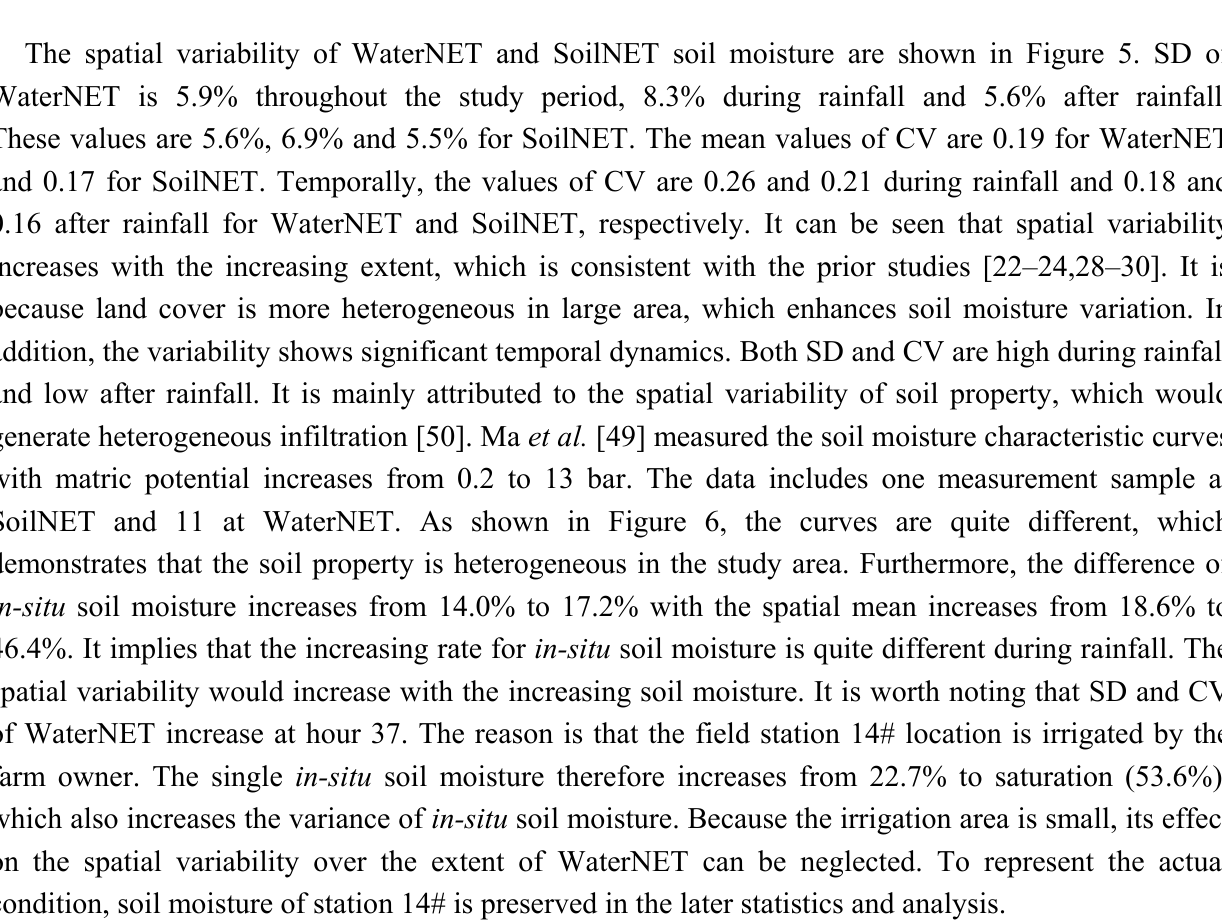
Figure 4. Comparison of the mean soil moisture of sub-WaterNET, WaterNET and